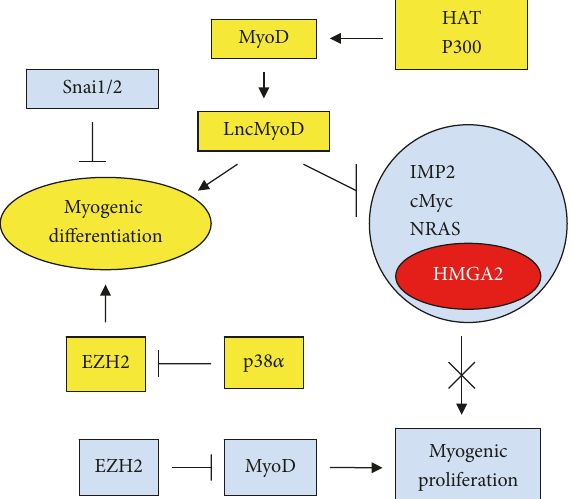
Figure 5: Relationship between MyoD, pluripotency factors, and EZH2 in myogenic differentiation. Symbols are the same as shown in Figure